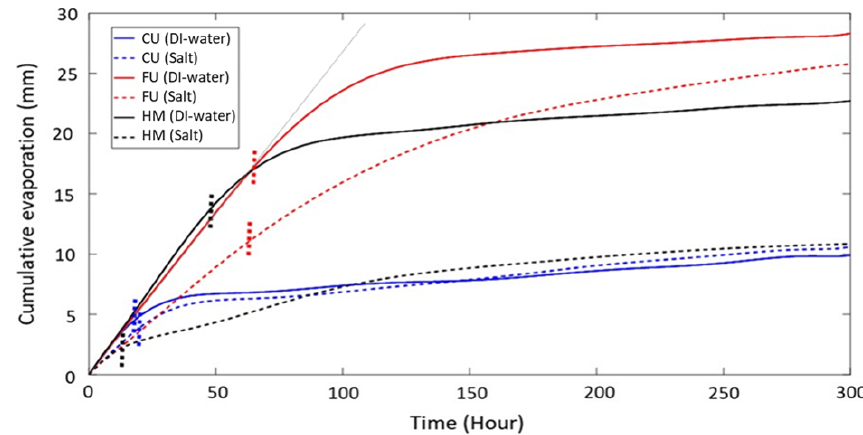
Figure 9. Cumulative evaporation for the Coarse-Up (CU), Fine-Up (FU), and the Homogeneous-Mixed (HM) structures for conditions of DI water (solid lines) and saline solution (dashed lines). Vertical dotted lines indicate the transition from S1 to S2. The thin gray line is an example of a tangent line used to identify the S1–S2 transition.